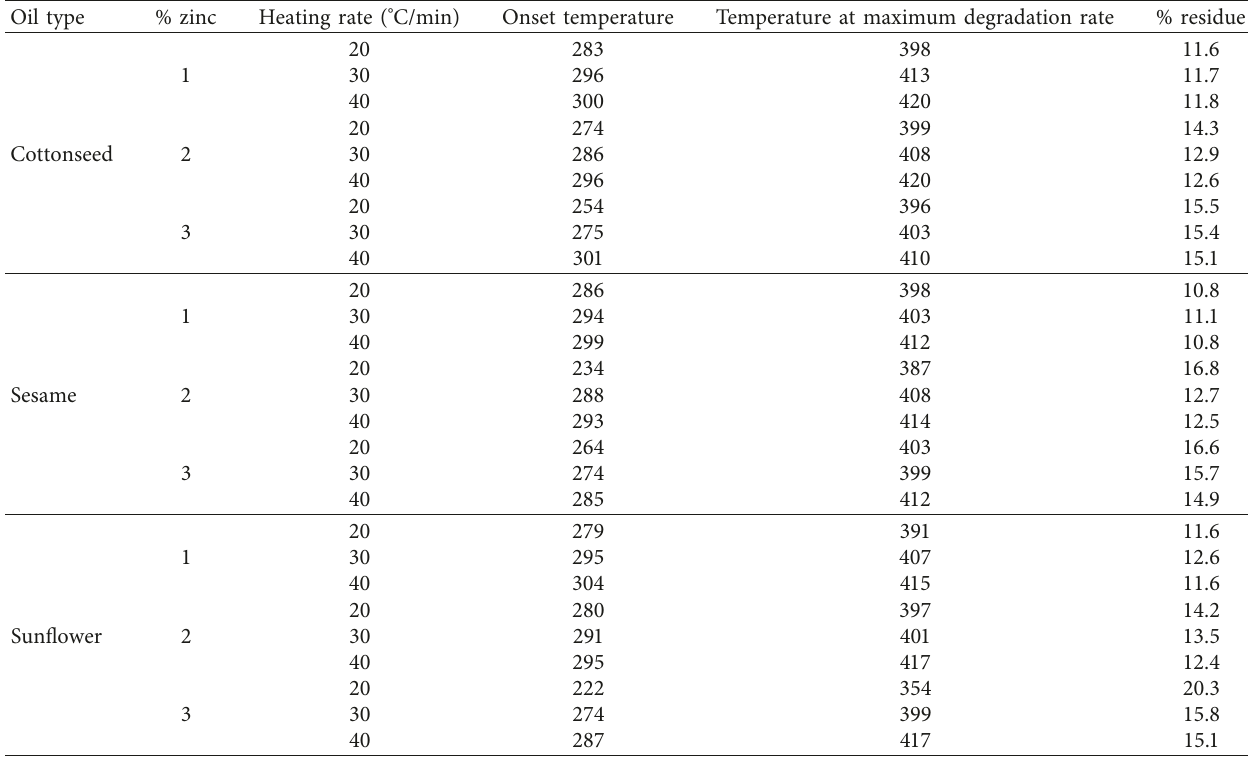
Table 1: Degradation onset and the temperature at the maximum degradation rate of gluten-based epoxy resin.